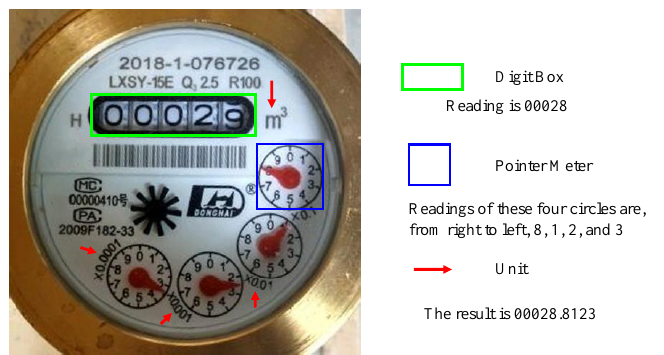
Figure 2. Schematic diagram of the watermeter. The weighted sum of the values of the digit box and the pointer meter indicates the water